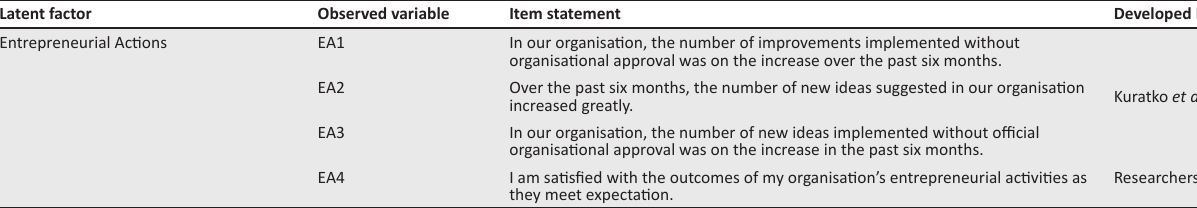
TABLE 1: Measurement scale for entrepreneurial actions. Latent factor Observed